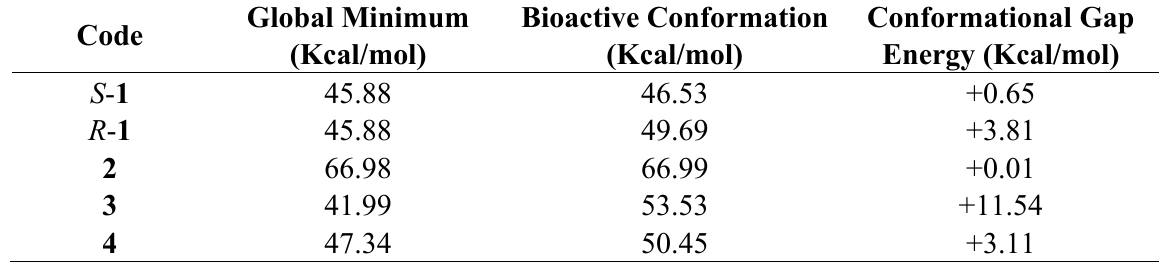
Table 3. Conformational energy values of tested